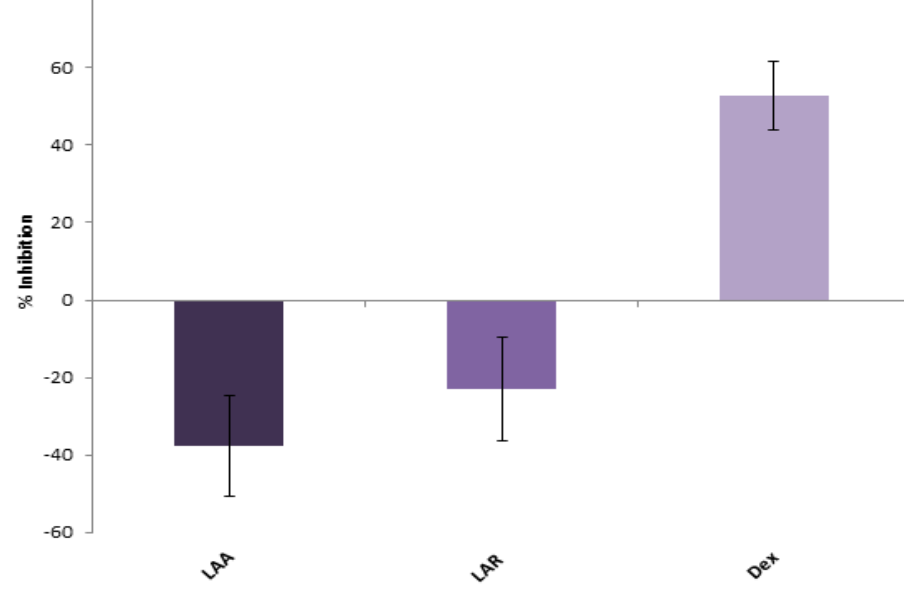
Figure 5. Inhibition (%) of COX-2 gene expression in macrophages of human leukemia cell line THP-1 by Lunaria annua methanolic extracts (LAA and LAR, 25 μg/mL). Dexamethasone (Dex; 2.5 nM) was used as a positive control. Data are expressed as mean ± SD of two independent experiments